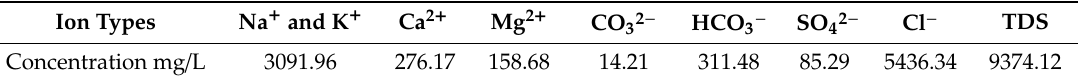
Table 1. Formation brine and injection brine